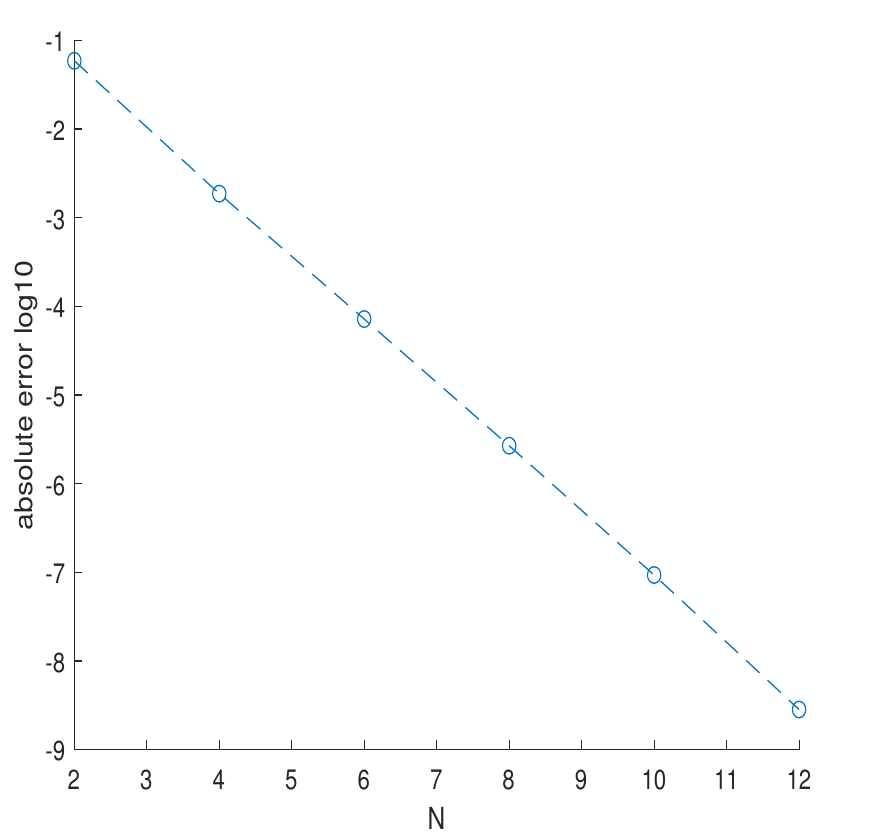
Figure 12. Log 10 of the absolute error versus N at ν = 1 for Example 5.